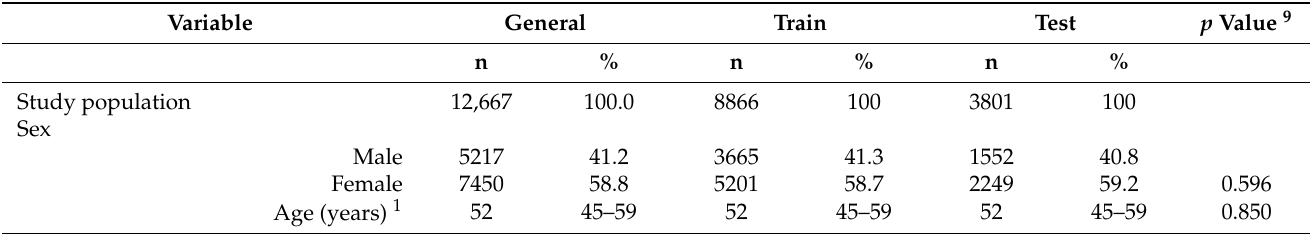
Table 1. Clinical and Socioeconomic characteristics of the study population, Brazilian Longitudinal Study of Adult Health (ELSA-Brasil),